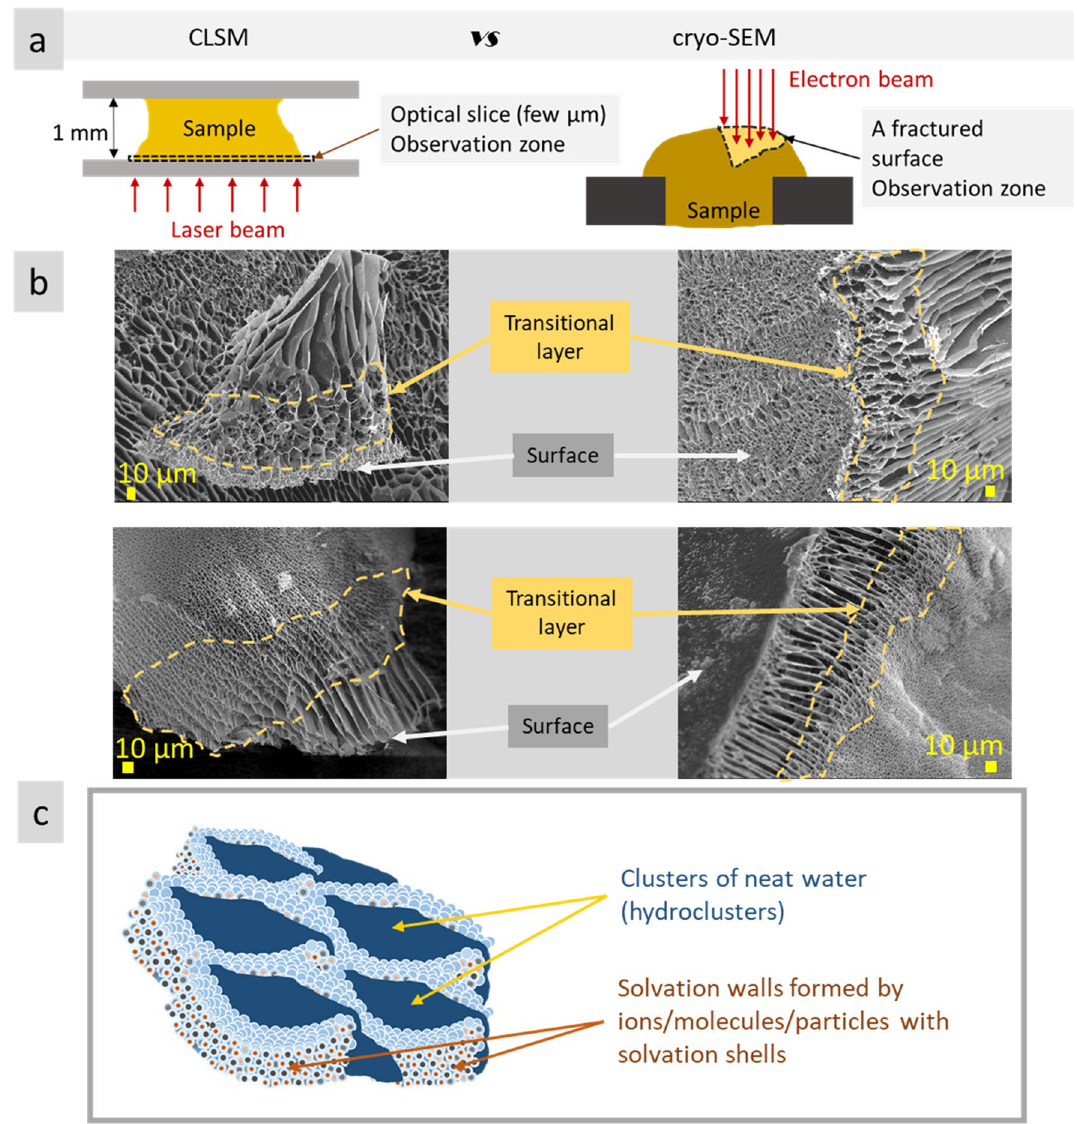
Figure 9. Scheme of sample observation at confocal LSM and cryo-SEM measurements ( a ); examples of microstructure scale transfer through transitional layers (circled by dotted line), from surface to bulk, in the polysaccharide gel at air/gel boundary 37 ( b ); scheme of dynamic solvation microstructure ( c